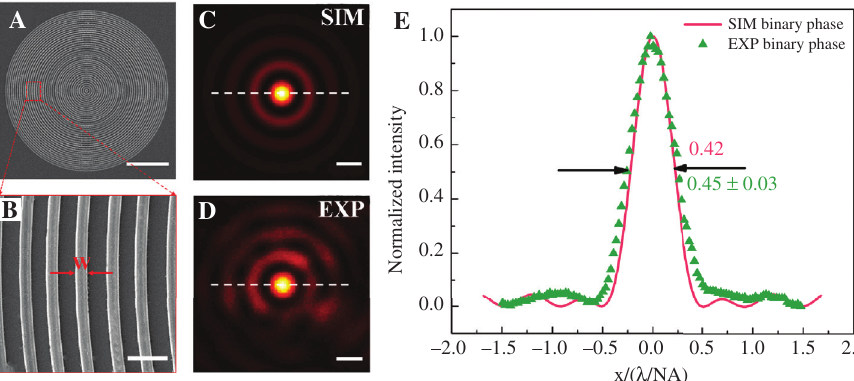
Figure 3: Binary phase-type SCL. (A, B) The SEM images of the binary phase-type SCL as fabricated with its related sectional zoom-in view. The binary phase SCL with a diameter of 197 μ m is consisted of 40 concentric belts with the width equaling to 1.2 μ m. Scale bars for (A) and (B) are 20 μ m and 3.6 μ m. Through precisely controlling the oscillating radius of the galvo mirrors, the belt width (W) of the SCL could be controlled at 1200 ± 50 nm. (C, D) Simulated and measured intensity distributions of the focal spot in the focal plane. Scale bar: 500 nm. (E) The intensity profiles of the focal spot along the dashed line, which shows sub-diffraction-limit focusing property and the agreement between the simulation data and the experimental